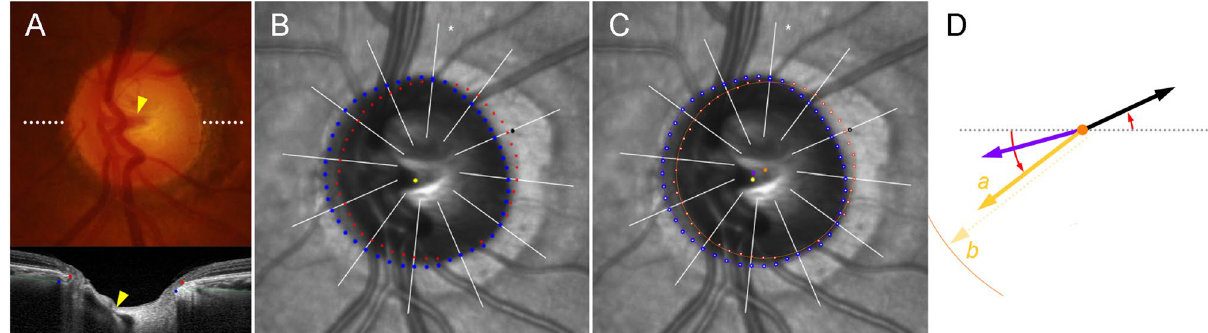
Figure 10. Determination of Bruch’s membrane opening (BMO), anterior scleral opening (ASCO), and central retinal vascular trunk (CRVT) (left eye of 65-year-old man without glaucoma, axial length of 23.72 mm). ( A ) Disc photograph and OCT image. The white dotted line indicates the location of the OCT scan, as targeted to the CRVT (arrowheads). The B-scan OCT image clearly shows the emergence of the CRVT. The red dots indicate the BMO margin. The ASCO margin (blue dots) was determined as the termination of the anterior scleral surface (green lines) at the optic nerve head canal. ( B ) Infrared image obtained by OCT. The margins of the BMO (red dots) and ASCO (blue dots) are demarcated. The CRVT position (yellow dot) and the meridian of the longest externally oblique border (EOB, black dot) are marked on the same infrared image. ( C ) Optimal ellipse fitting to obtain BMO and ASCO centers. Recognition of every point by our software is expressed by an inner white dot. The best-fitted ellipse for the BMO (orange ellipse) and the ASCO (purple ellipse) are drawn in reference to their centers (orange dot for BMO center, purple dot for ASCO center). ( D ) Calculation of offsets from given set of dots. From the BMO center (orange dot), the angular deviation of CRVT (yellow arrow), and ASCO center (purple arrow) are measured clockwise, with the nasal horizontal midline as 0°. A positive value indicates the superior location and a negative value indicates the inferior location. Likewise, the meridian of the longest EOB (black arrow) is measured clockwise, with the temporal horizontal midline as 0°. A positive value indicates the superior location and a negative value indicates the inferior location. From the BMO center, the distances are measured to the CRVT ( a ) and to the BMO margin in the same direction ( b ). The ratio of these distances is defined as the “shift index” ( a / b ), which is used to measure the extent of shift. The extent of CRVT offset (yellow arrow) divided by that of ASCO offset (purple arrow) is defined as the “offset